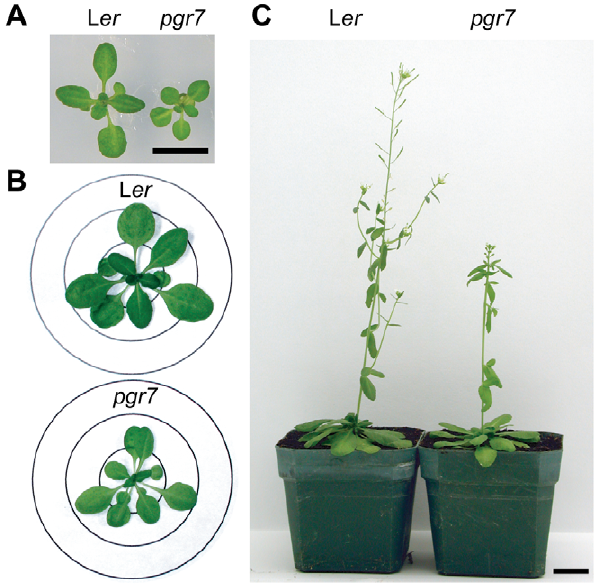
Figure 2. Comparisons of plant size and development between pgr7 and L er . A) Seedlings grown on MS-salt agar plate for 2 weeks under continuous light. The bar represents 1 cm. B) Plants grown in soil in a short day condition (10 hours light/14 hours dark) for 4 weeks. The diameters of the circles are 2, 4 and 6 cm. C) Plants grown in soil in a short day condition (10 hours light/14 hours dark) for 8 weeks. The bar represents 2.5 cm.